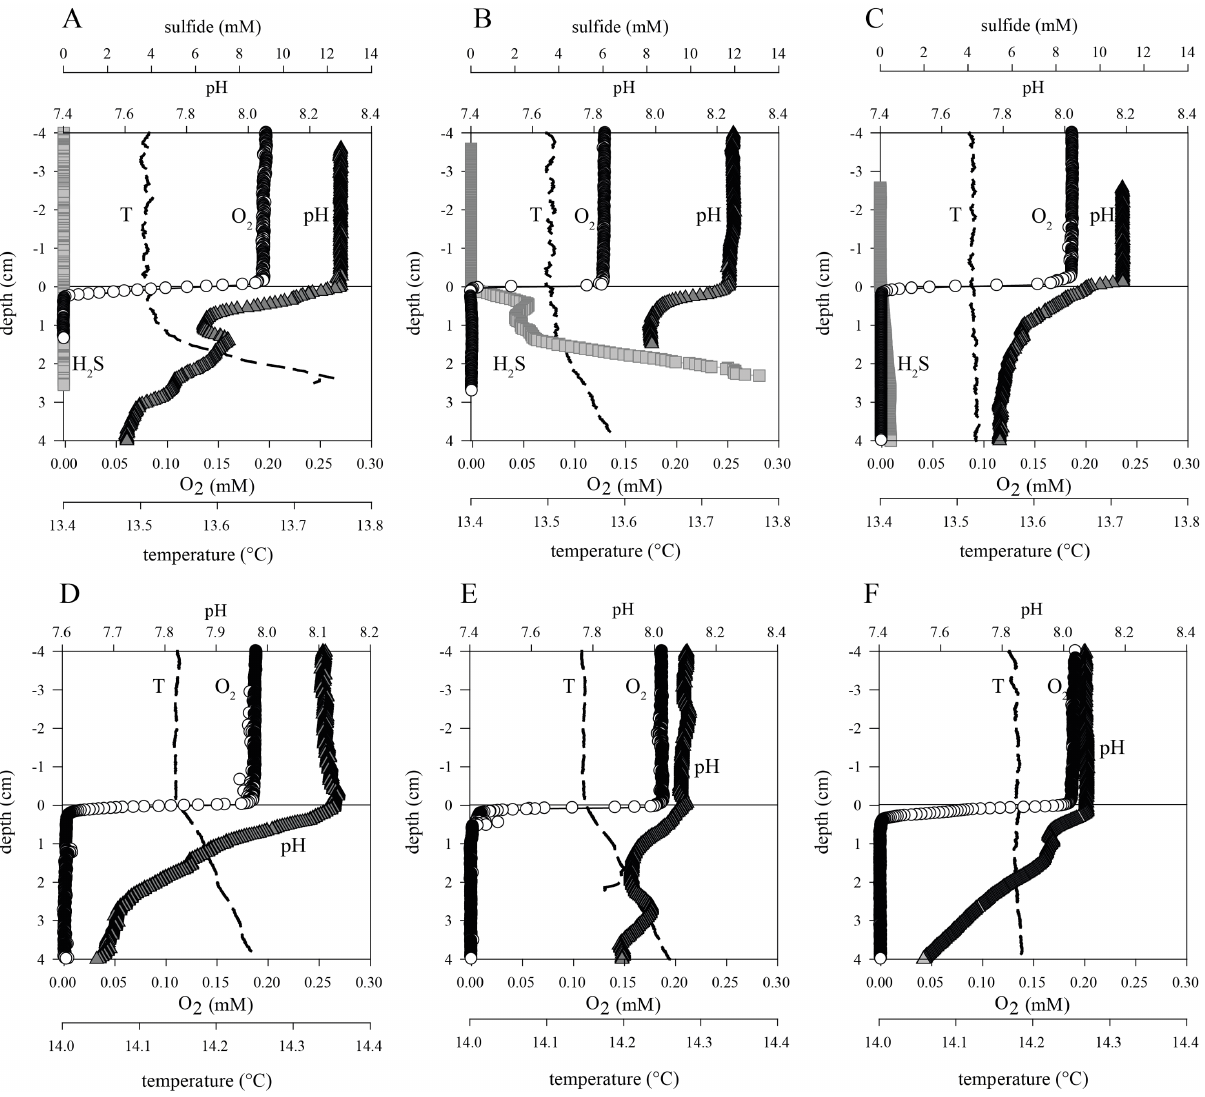
Fig. 5. Microsensor measurements from the (A) , (D) central dome (I); (B) , (E) the bacterial mat (II) site; (C) , (F) the bacterial mats at the sulfur band (IV). The profiles show oxygen (O2) (white spheres), total sulfide (H2S) (grey line) concentrations, pH (grey triangles), and temperature ( T , dashed line). (A–C) and (D–F) are profiles measured in 2006 and 2009, respectively. In 2009 no sulfide was measured due to failure of the respective microsensor